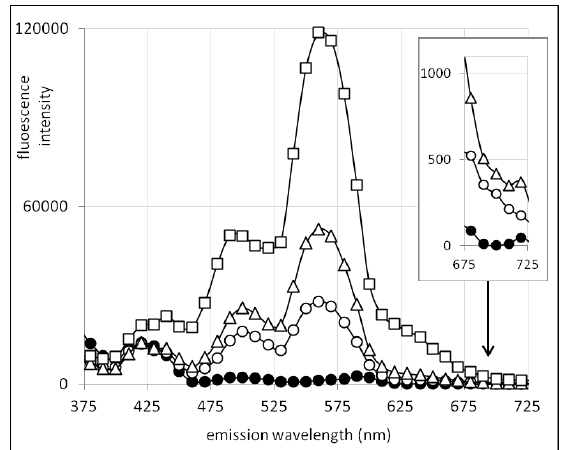
Figure 1. Time-course of appearance of heme break- down products in erythrocyte lysate in the presence of 0.5% ascorbate. Human erythrocyte lysate was scanned for fluorescence emission from 375 to 725 nm after incubation at room temperature for 1 h ( o ( ), 3 h ( D ) and 4 h ( ¤ ). The arrow denotes the wave- length at which the emission of Alexa 660 was moni- tored for folate quantification. The inset box shows the increasing erythrocyte lysate emission at 690 nm with time (1, 2, and 3 h).